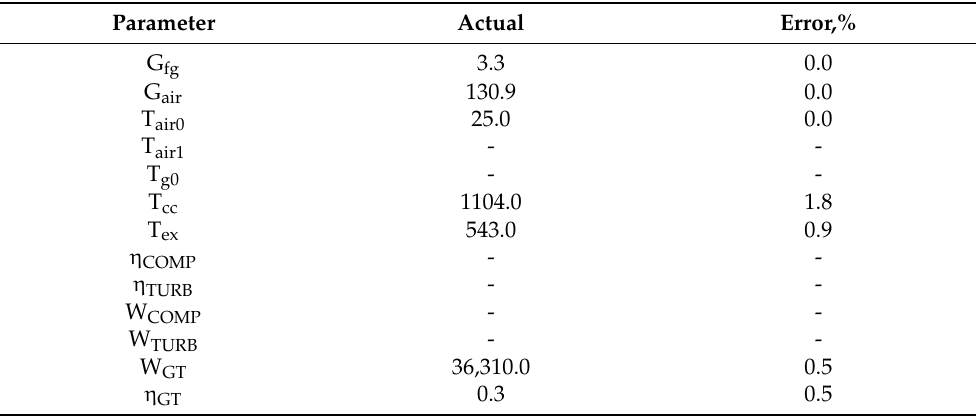
Table 4. Description of the